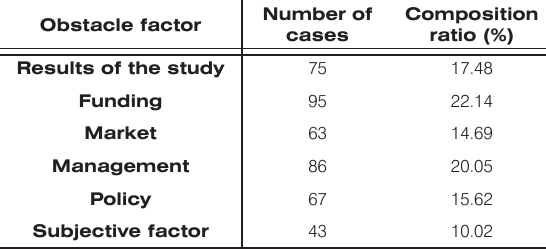
Table 7. Factors affecting the application of the results of clinical nursing